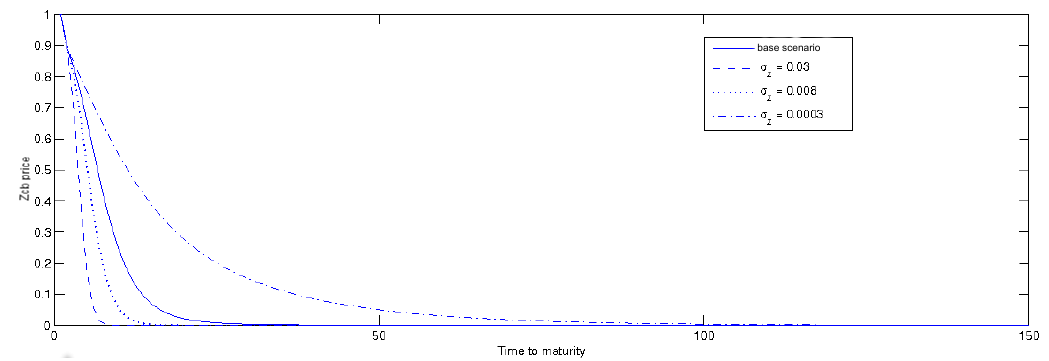
Figure 3. Zero coupon bond price in different hypothesis of economic cycle